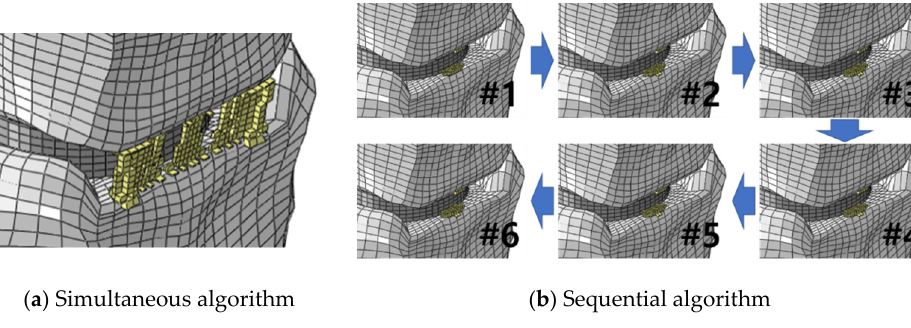
Figure 5. Bone formation during flexion using the two algorithms.